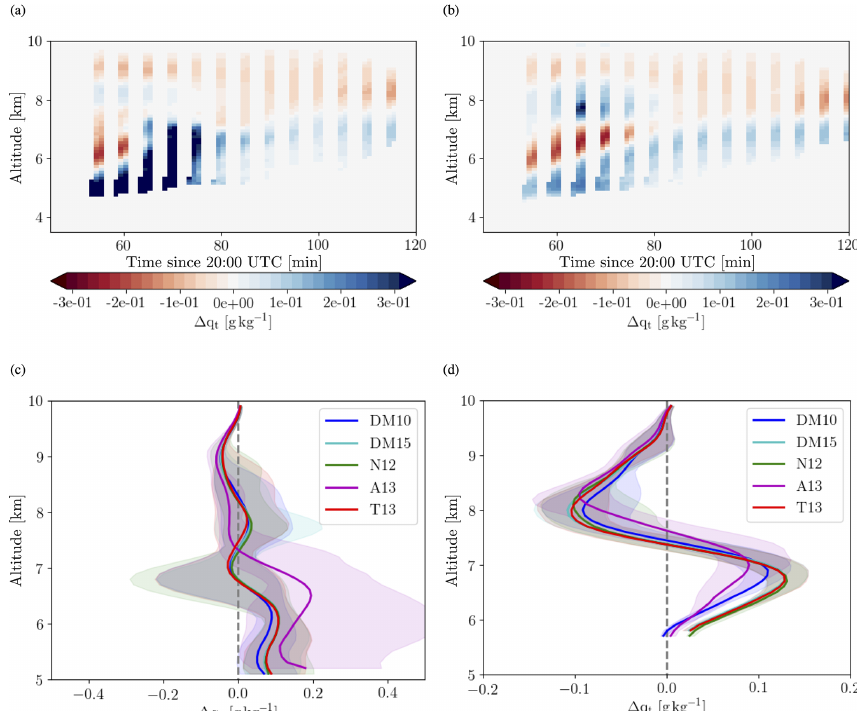
Figure 7. (a, b) Difference in total water mass mixing ratio (cid:49)q t between − 105 . 35 ◦ E (upstream) and − 104 . 78 ◦ E (downstream) along backward trajectories for simulations using the (a) A13 and the (b) DM10 ice nucleation parameterization. The differences are calculated as downstream values minus upstream values. The plot shows values at 42.1 ◦ N, i.e. downstream of the centre of the wave cloud. The times on the abscissa indicate the arrival time of the trajectories at the downstream location. (c, d) Mean profiles of (cid:49)q t for all simulations averaged between (c) 21:10 and 21:30 and (d) 21:40 and 22:00UTC. The different colours correspond to simulations with different ice nucleation parameterizations, while the shading represents the temporal variability in the profiles. Note the travel time of the trajectories between the upstream and the downstream location is about 30 and